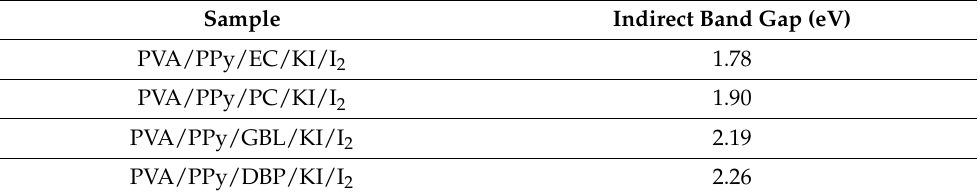
Table 2. Indirect band gap energy of the PVA/PPy/KI/I 2 electrolyte with different plasticizers. Sample Indirect Band Gap